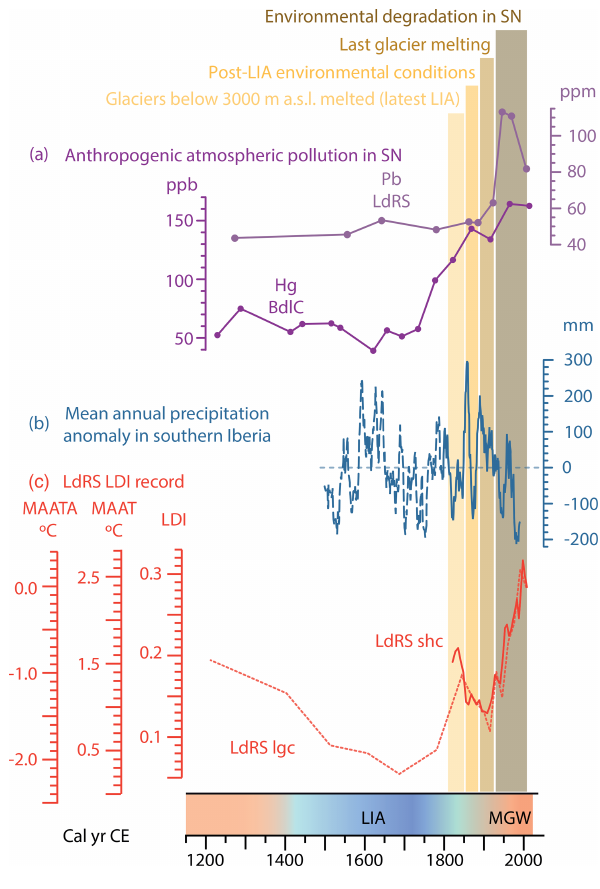
Figure 8. Comparison among different factors affecting the en- vironmental evolution of alpine wetlands in the Sierra Nevada. (a) Records of anthropogenic heavy-metal atmospheric pollution (Pb and Hg) in two alpine sites of the Sierra Nevada: Laguna de Río Seco (LdRS) and Borreguil de la Caldera (BdlC) (Garcia-Alix et al., 2013, 2017); (b) mean annual precipitation anomaly in south- ern Iberia from 1500 to 1990CE with respect to the mean value of the instrumental period (1791–1990CE): solid line – instrumen- tal data from Gibraltar (southern Iberia); dashed line – precipita- tion anomaly reconstruction (Rodrigo et al., 1999); (c) LDI and reconstructed temperatures in LdRS. Color bars indicate the four main environmental stages in the Sierra Nevada (SN) during the last 200 years. Acronyms: LIA, Little Ice Age; MGW, modern global